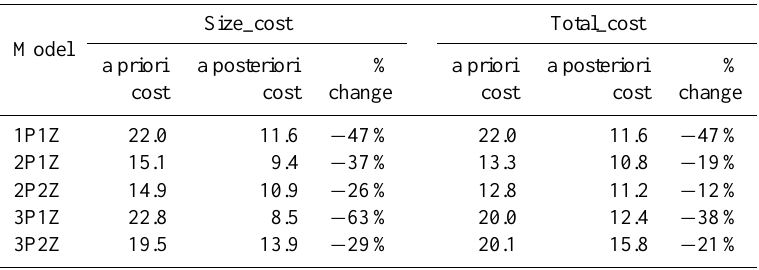
Table 3. Cost functions (Size_cost and Total_cost) computed at the four DA sites in experiment 2, using initial parameter values (i.e., a priori cost) and optimal parameter values obtained from the assimilation of satellite-derived size-fractionated chlorophyll and POC data at the four DA sites (i.e., a posteriori cost).